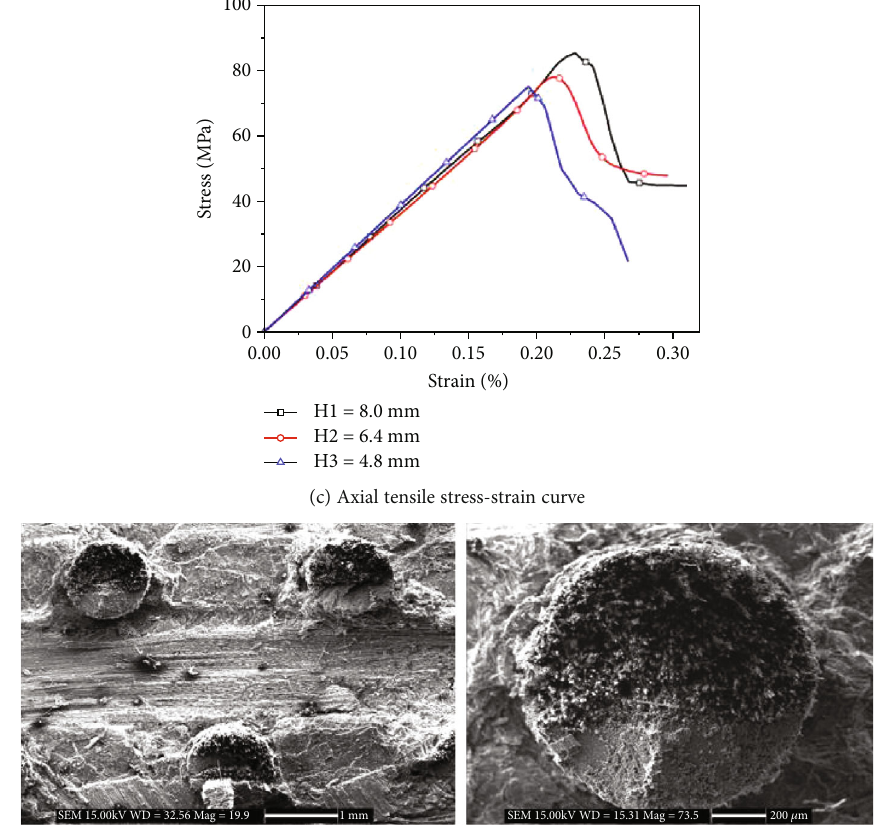
Figure 8: Axial tensile test